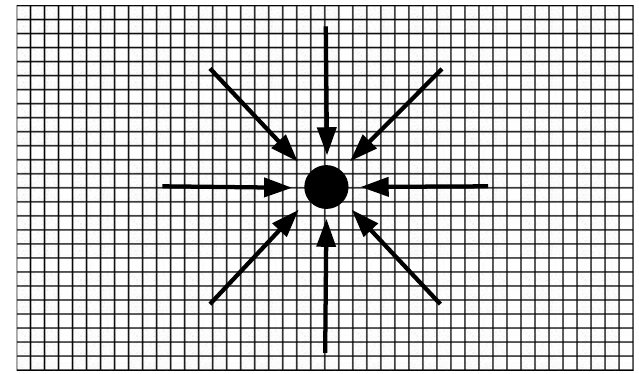
Figure 2: In this figure, we present a conceptual rendering of the central notion used for the verification of the EPR argument, namely, the pressure experienced by extended particles immersed in hyperdense media, such as a proton in the core of a star, which pressure evidently restricts uncertainties in favor of Einstein’s determinism (Lemma II- 3.7). Note that the notion of pressure does not exist in 20th century physics due to the approximation of particles as being